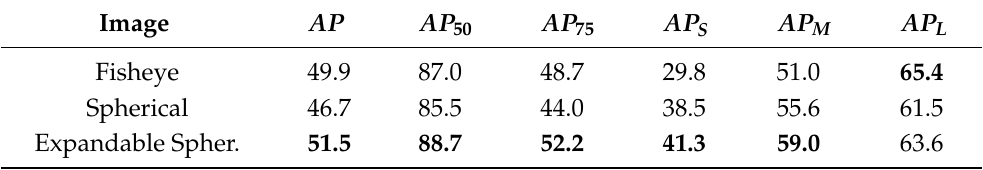
Table 16. Accuracy of different projections of SLCat model on the Fisheye-Dongseongro.